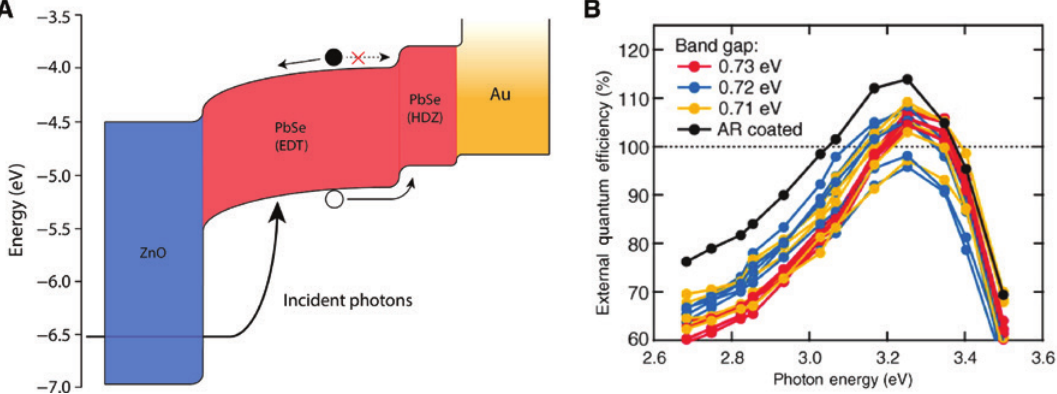
Figure 4: Device architecture and EQEs > 100% for PbSe quantum dot-containing solar cells. (A) Energy landscape of a solar cell based upon PbSe QDs which have been treated with 1,2-ethanedithiol (EDT) or hydrazine (HDZ). The difference in doping density in electron acceptor (ZnO) and QD film produces a depletion region within the QD layer, which drives charge extraction after free carriers have been generated. (B) External quantum efficiency (EQE) of the same PV device architecture showing the high-energy region for three different PbSe QD sizes. All QD sizes demonstrate the generation of more than one carrier produced per inci- = 3.3 eV. Part B has been taken from dent photon at h ν photon